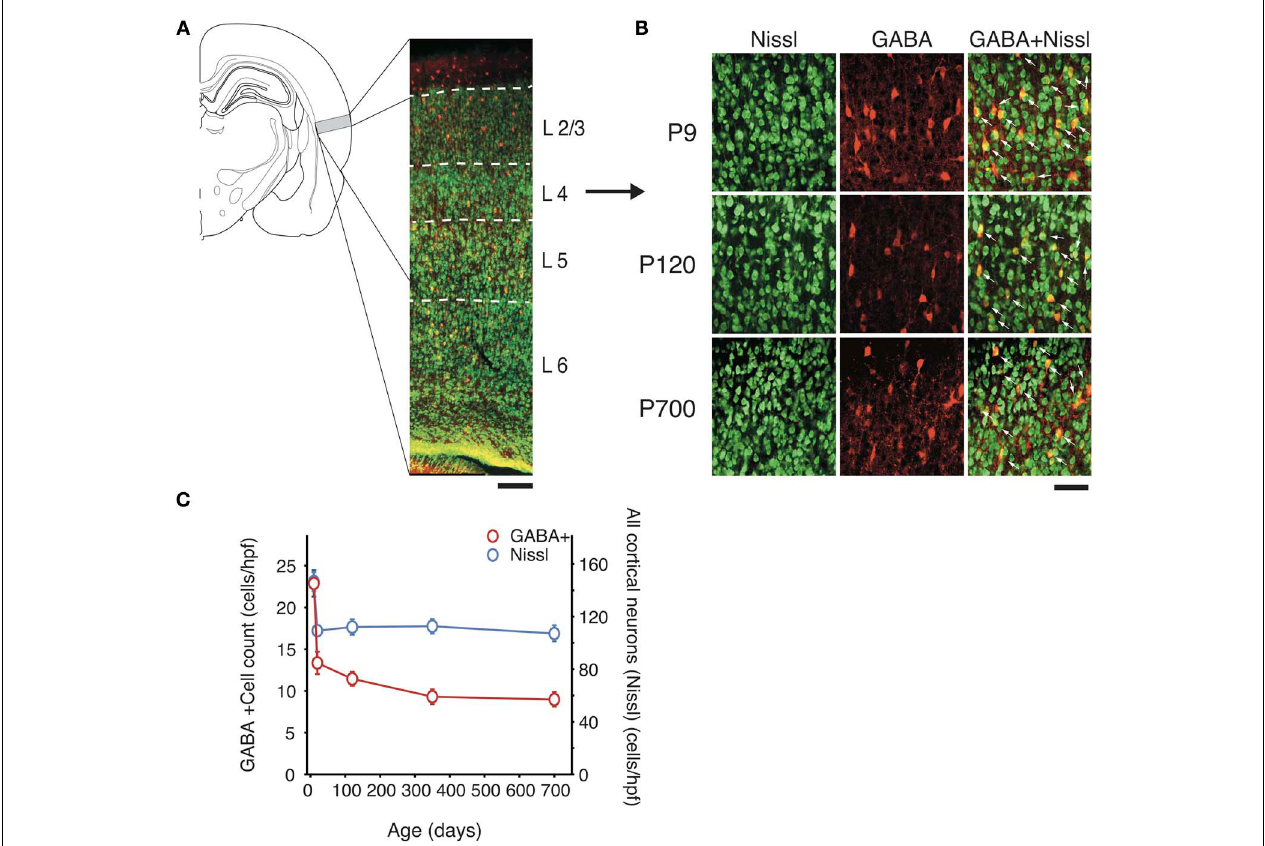
FIGURE 1 | Total GABAergic cell count and global neuron count across the lifespan in A1. (A) Left , Schematic representation of the location of A1 in the rat brain and, right , low power confocal photomicrograph (10X) showing a representative section of the full thickness of A1 (pia up) with cortical layer borders. Neuron-specific Nissl staining is shown in green and GABA staining in red. Scale bar: 100 μ m. (B) Representative high power